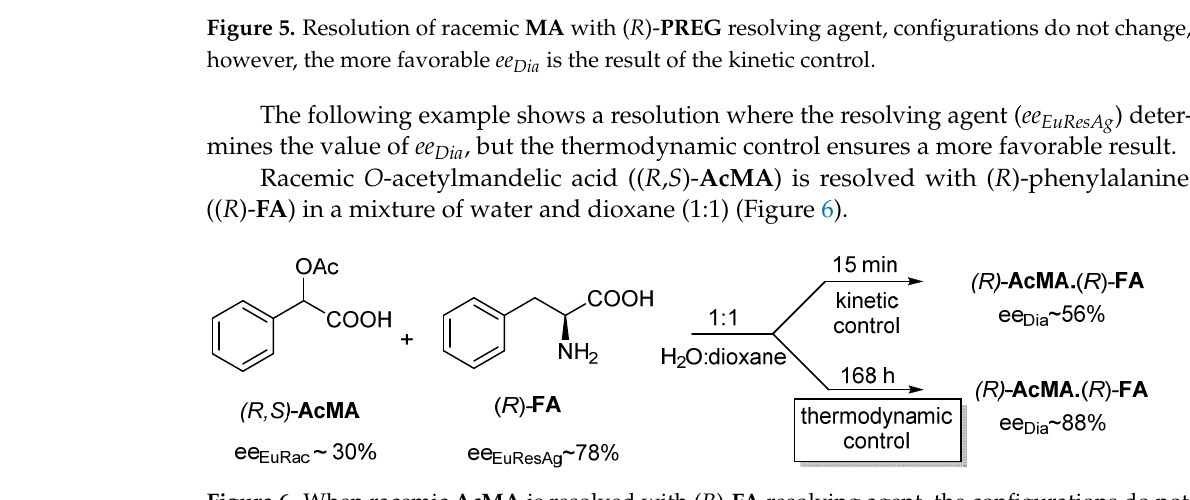
Figure 6. When racemic AcMA is resolved with ( R )- FA resolving agent, the configurations do not change; however, the more favorable ee Dia is the result of the thermodynamic control.